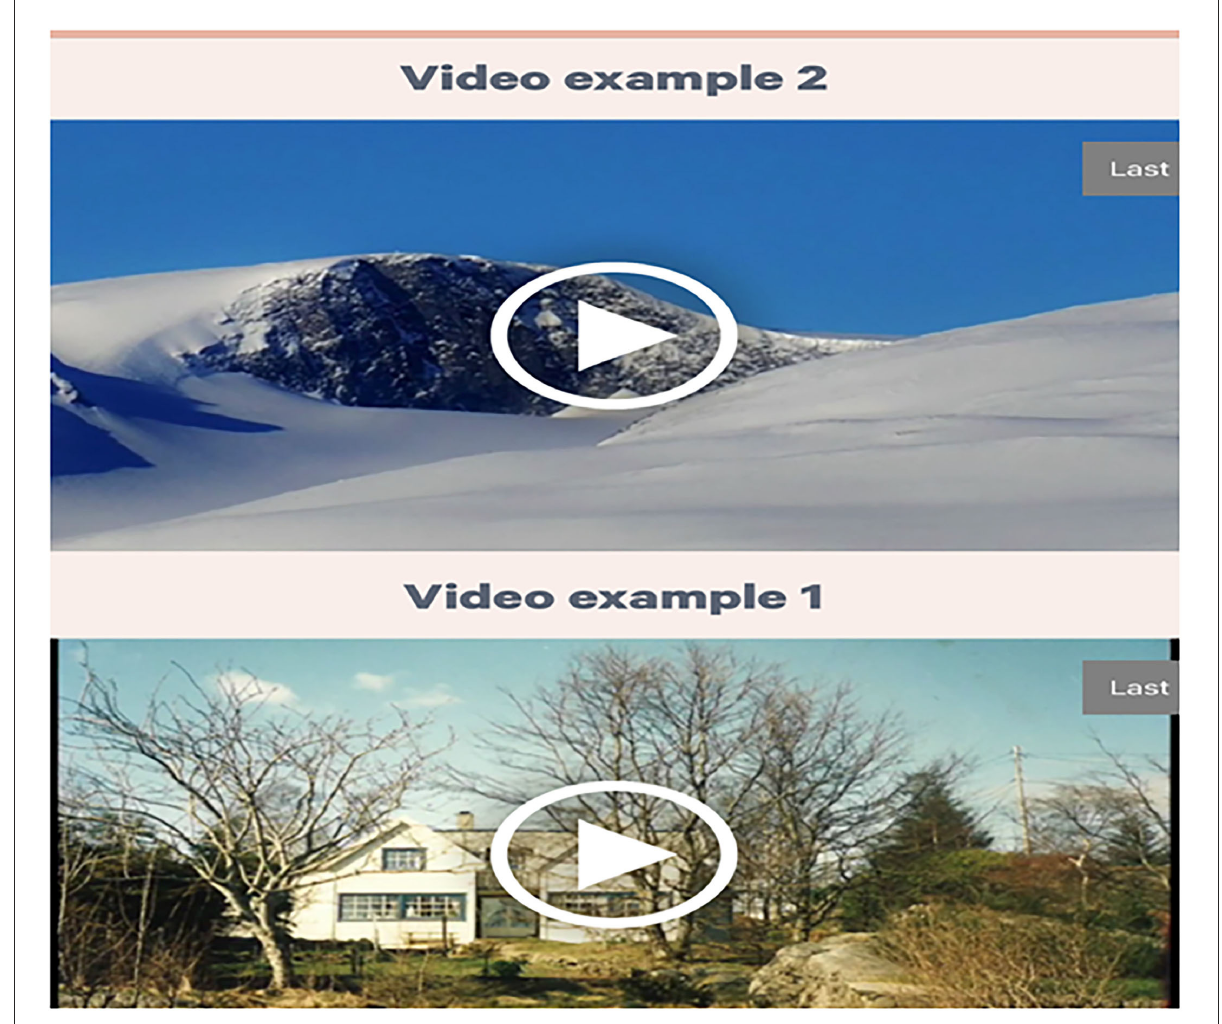
FIGURE2 Screenshot of a launch page in the Alight application. The user presses the ≪ play ≫ icon to start the